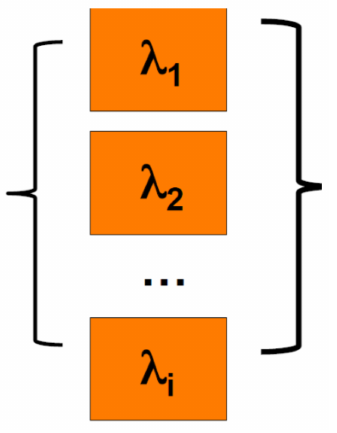
Figure 10. Failure of devices oriented in a parallel